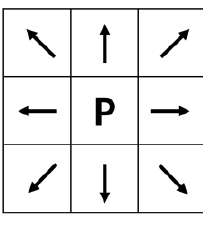
Figure 2. Schematic of the Eight-Neighborhood method. P is the distance database to be queried. The eight arrows represent the eight neighborhoods of P. eight arrows represent the eight neighborhoods of